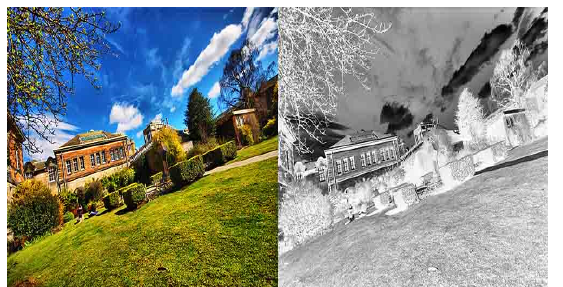
Fig. 3: How we see the world and the actual world There are two different ways to use an organic light- emitting diode for displays: (i) Using white color OLED as a backlight, (ii) Producing RGB color from OLED to create an image. RGB stands for red, green, and blue. These three colors are basic; with the combination of these three colors, we can produce every color. The spectrum of light that is visible to the human eye is 380nm to 700nm [26]. The light with a short wavelength has pigment absorbing maximum at around 420 nm with blue color dominant, medium wavelengths at 530 nm with dominant green color, and large wavelength at 600nm with dominant red color [27]. The ranges of wavelength and frequency to color produced are represented in Table 1 [26].